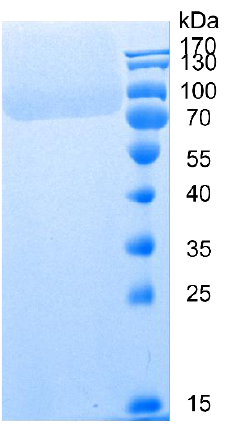
Figure 3. SDS – PAGE of